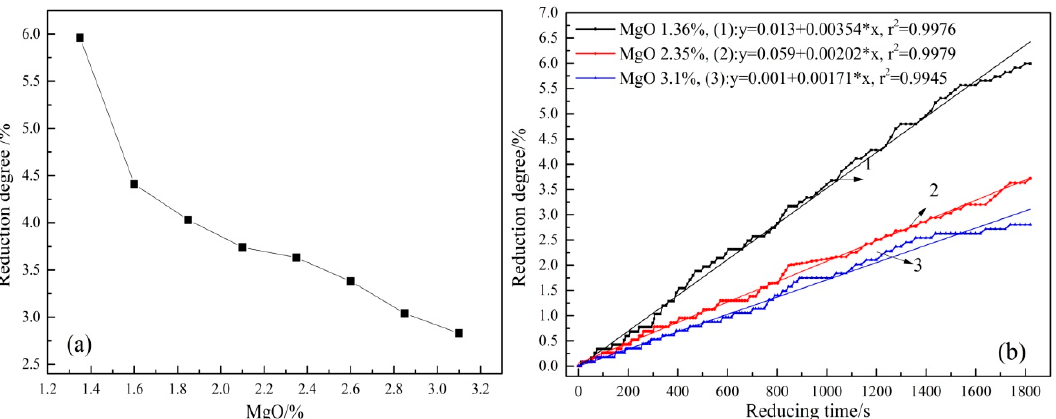
Figure 3. ( a )Effects of MgO on reduction degree of sinter at low temperature in simulated COREX shaft furnace condition; ( b ) changing reduction degree over time of sinter.